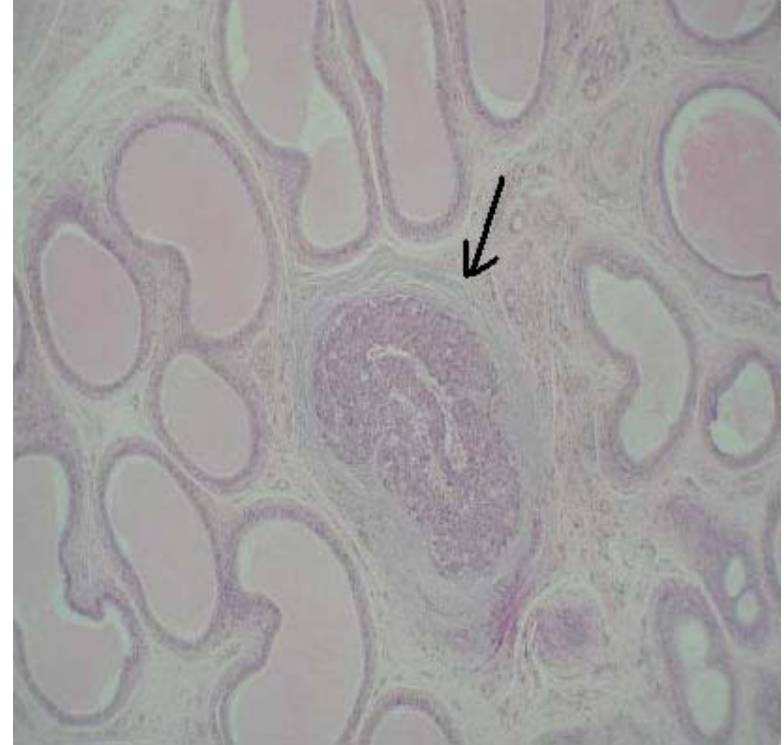
FIGURE 2. Histology slide showing metastatic change in the epididymis (shown with black